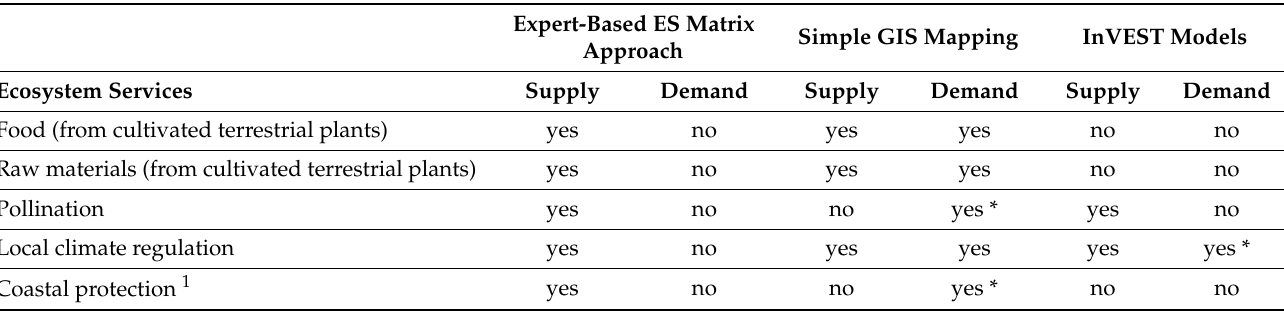
Table 3. Overview of the mapping outcomes. Method 1: Expert-based ES matrix approach, Method 2 = proxy indicators and data, Method 3 = InVEST models; Mapping outcome: yes = ES component could be mapped, yes * = ES component could be mapped, but not for the whole case- study region, no = ES component could not be mapped. Expert-Based ES Matrix Simple GIS Approach